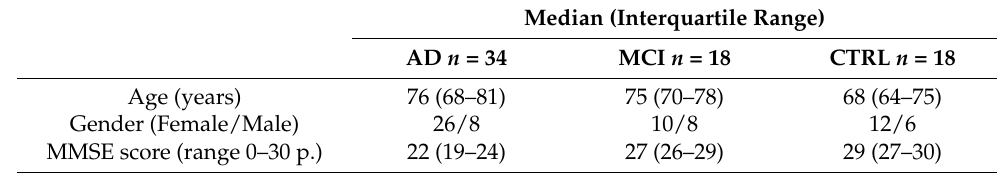
Table 2. Demographic data and characteristics of the study